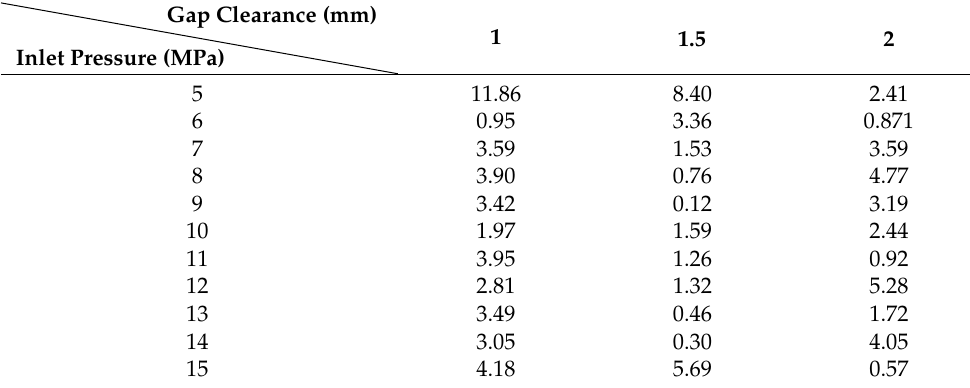
Table 4. Relative errors (%) for the original suction cup.